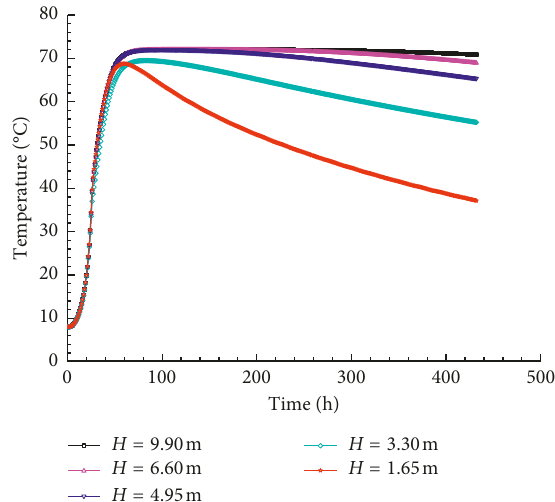
Figure 15: Core temperature evolution of foundations with various raft thicknesses.